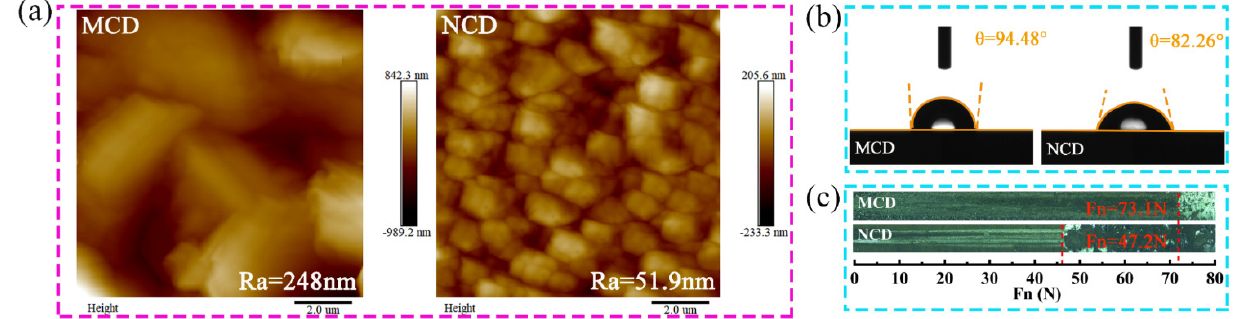
Figure 3. ( a ) The AFM three-dimensional morphologies of diamond coatings; ( b ) The wetting angle of the sea water on the diamond coatings; ( c ) Scratch morphologies of diamond coatings.